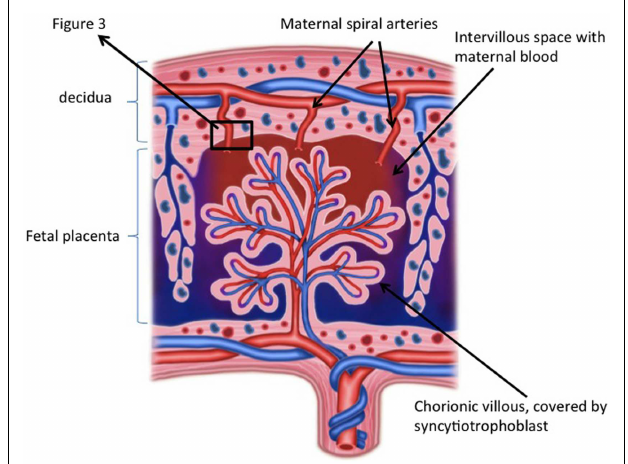
FIGURE 1 | Schematic overview of the placenta .The placenta consists of a fetal part and a maternal part. In the fetal part of the placenta, chorionic villi, covered with syncytiotrophoblast, bath in maternal blood of the intervillous space. Direct or indirect contact (via soluble factors) of monocytes with the syncytiotrophoblast may results in monocyte activation.The maternal part of the placenta consists of decidua in which remodeled spiral arteries are present, which take maternal blood to the intervillous space. In the decidua fetal trophoblast, and maternal macrophages and NK cells are present and necessary for immune regulation and spiral artery remodeling ©ilusjessy –